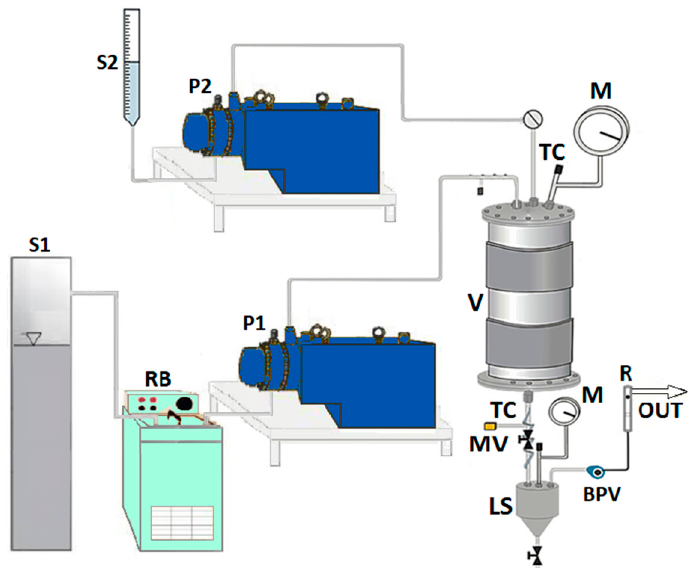
Figure 1. A sketch of the supercritical antisolvent (SAS) laboratory plant. S1, tank for the CO 2 ; S2, organic solution; RB, refrigerating bath; P1, P2, pumps; V, vessel; M, manometer; TC, thermocouple; MV, micrometric valve; LS, liquid separator; BPV, back-pressure valve; R, rotameter.